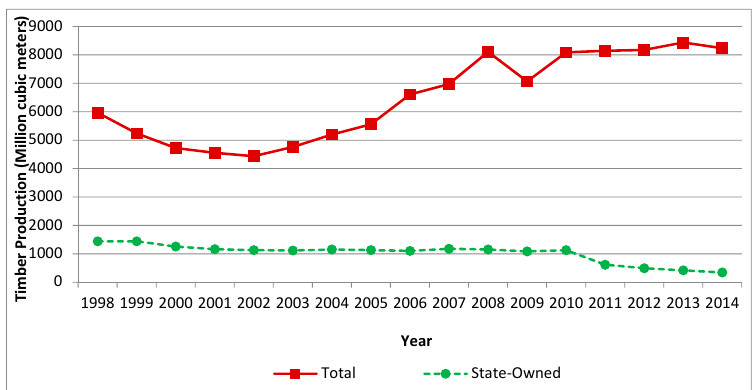
Figure 1. China’s total domestic timber production and the contribution of state-owned forestland. Notes: (1) Data sources: China Forestry Statistical Yearbook, 1998–2014; state-owned forestland timber production data are drawn from data on 135 key state-owned timber harvesting firms and 20 key state-owned forestland management bureaus. (2) Given the impact of the freezing rain and snow disaster and earthquakes, timber production in 2008 increased dramatically and returned to normal levels in 2009